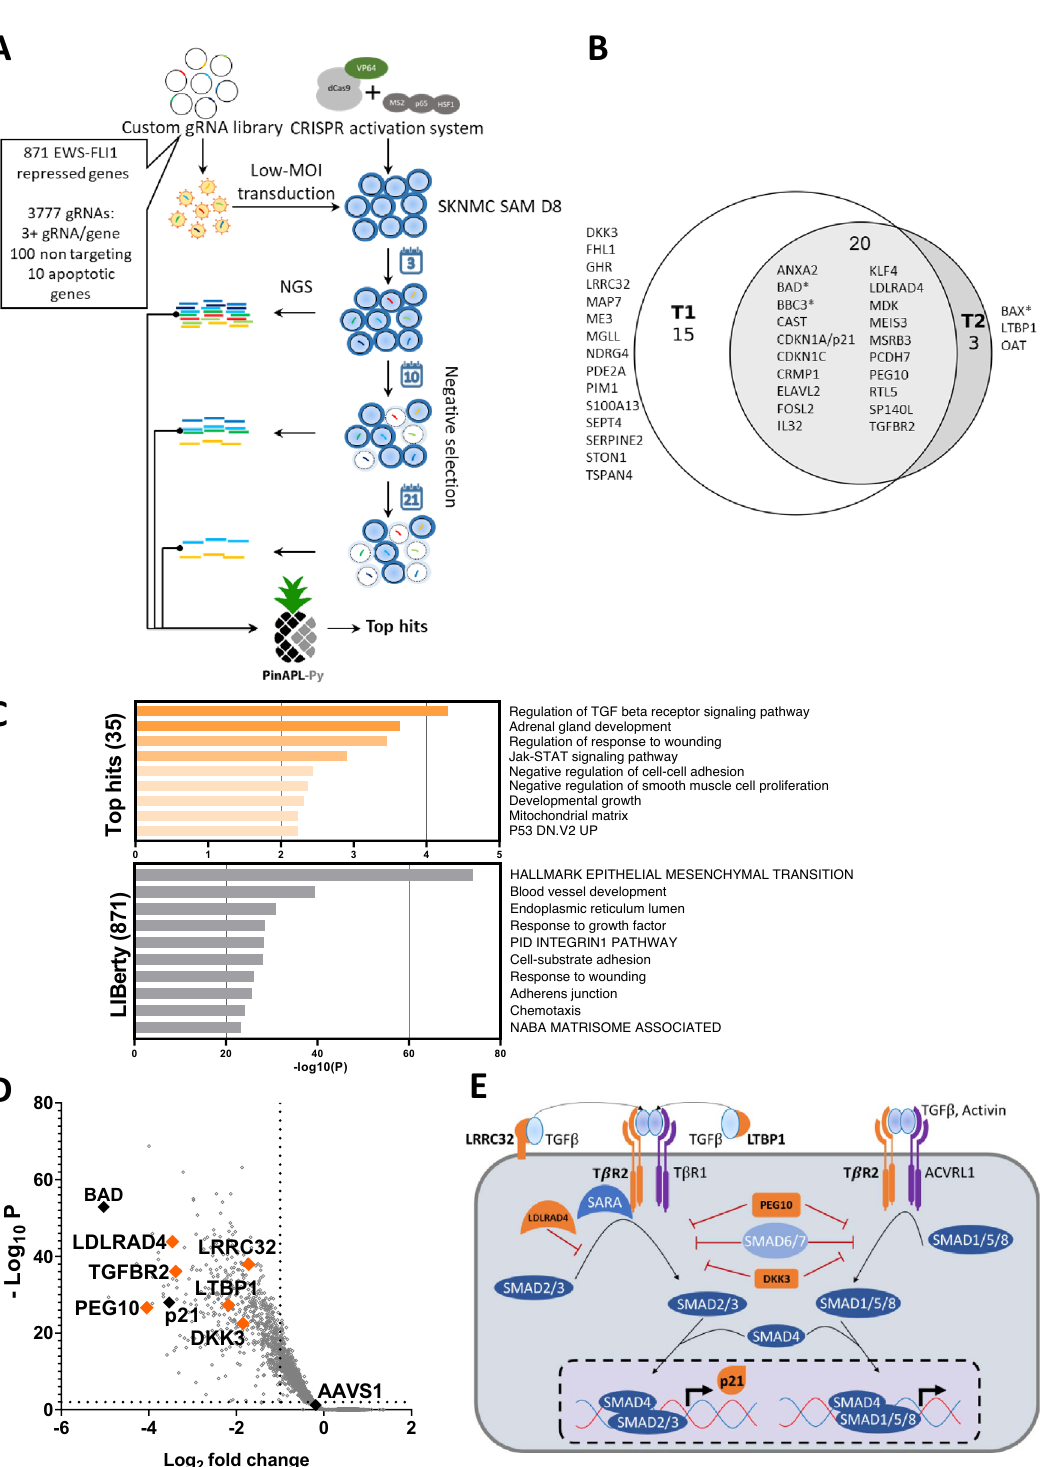
Figure 2. Top candidate genes identified by the CRISPRa dropout screen. (A ) Schematic representation of the CRISPRa dropout screen. ( B ) List of 35 top-ranked genes grouped by timepoint (T1—10 days post transduction, T2—21 days post transduction). Genes marked with an asterisk are positive controls. 19 genes were identified at both time points ( C ) Metascape GO-term analysis of all 35 top candidates (upper panel) and the entire library (lower panel). Image was created by using GraphPad version 8, https:// www. graph pad. com. ( D ) Result of the screen from time point 1. Each dot represents a single gRNA. Best performing gRNAs are labeled with the symbol of corresponding target gene. Controls are indicated in black, genes belonging to the TGFβ pathway in orange. Image was created by using GraphPad version 8, https:// www. graph pad. com. ( E ) Schematic representation of the candidate gene hits in the TGFβ pathway indicated in